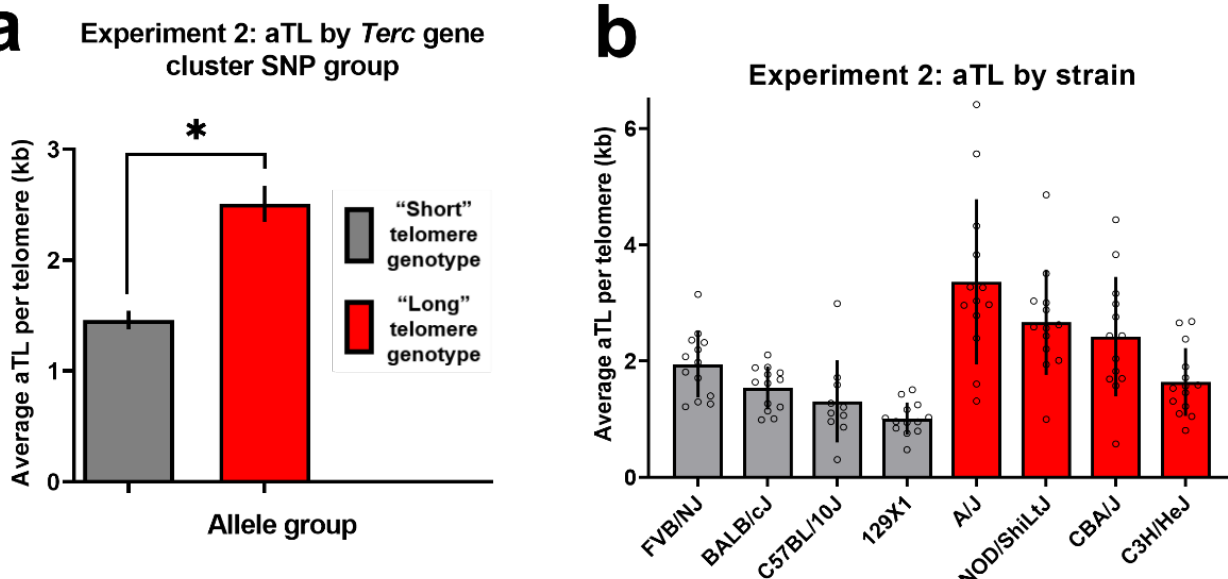
Figure 3. ( a ) Average liver aTL per telomere (kb) in Experiment 2 inbred mouse strains, by genotype group. “Short” genotype n = 49; “Long” genotype n = 53. * Indicates significant main effect at ANOVA significance threshold of 0.05. ( b ) Average liver aTL per telomere (kb) in Experiment 2 inbred mouse strains, shown by strain. Unfilled circles indicate individual datapoints per strain. n = 10–14 per strain.